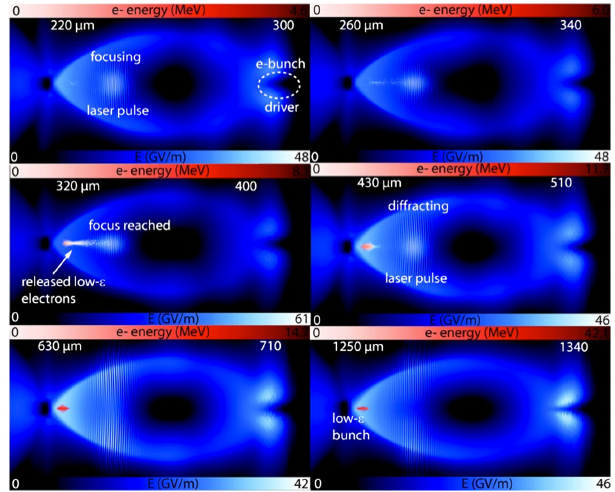
FIG. 1. PIC simulation snapshots of photoionization release, trapping, and acceleration of electrons inside a bunch-driven, self-ionized plasma blowout. The copropagating laser pulse starts toreleaseelectronsasitapproachesitsfocus.Theselow-emittance electrons are trapped at the back of the blowout and gain energy (red color bar). The blue and white colors show the sum of the electric field, which is necessary to indicate the bubble structure as well as the linearly polarized laser pulse electric